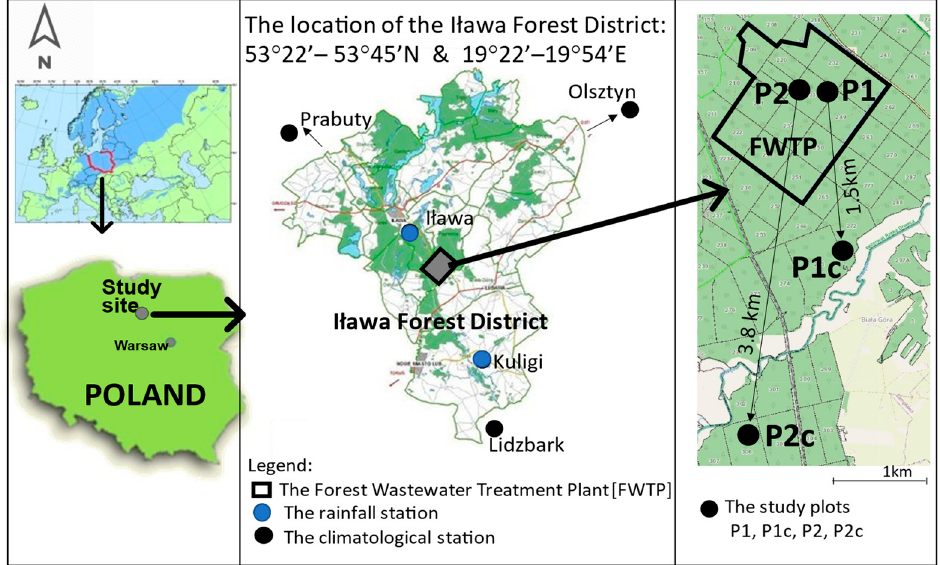
Figure 1. Location of the study plots (explanation of abbreviations in the figure on the right: P1 and P2—study plots within the FWTP; P1c and P2c—control stands).